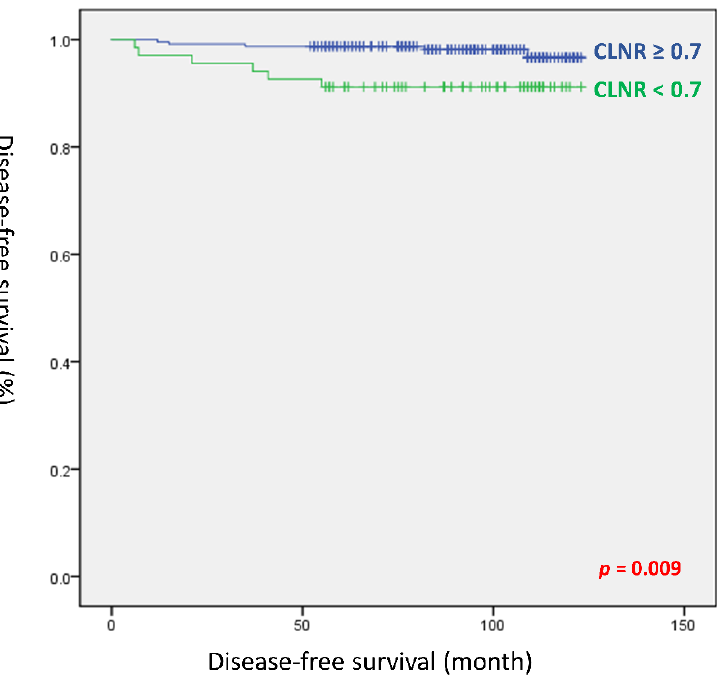
Figure 2. Disease-free survival curves according to the central lymph node ratio (log-rank p = 0.009).